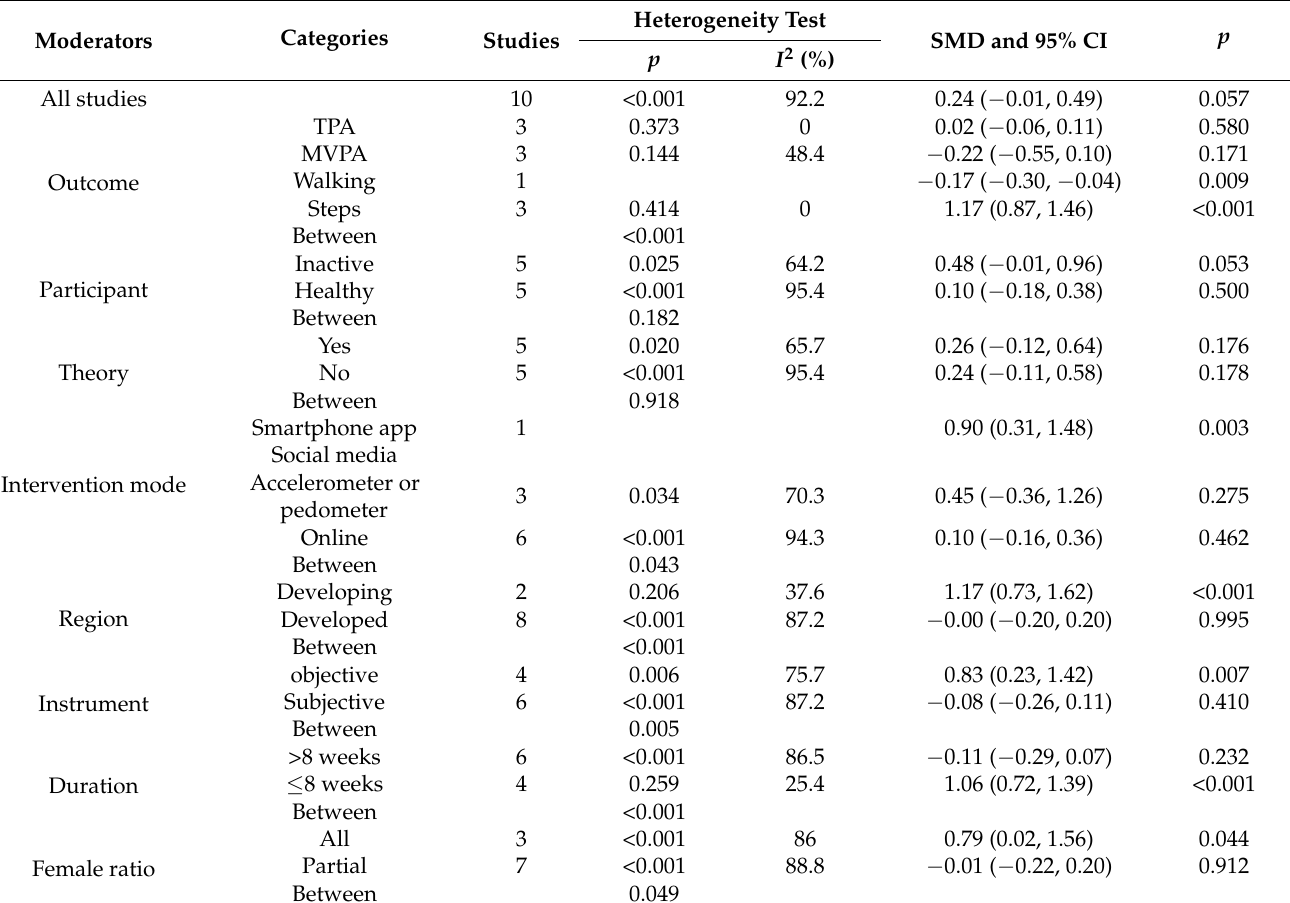
Table 2. Subgroup analyses of the effects of e-health interventions on PA at